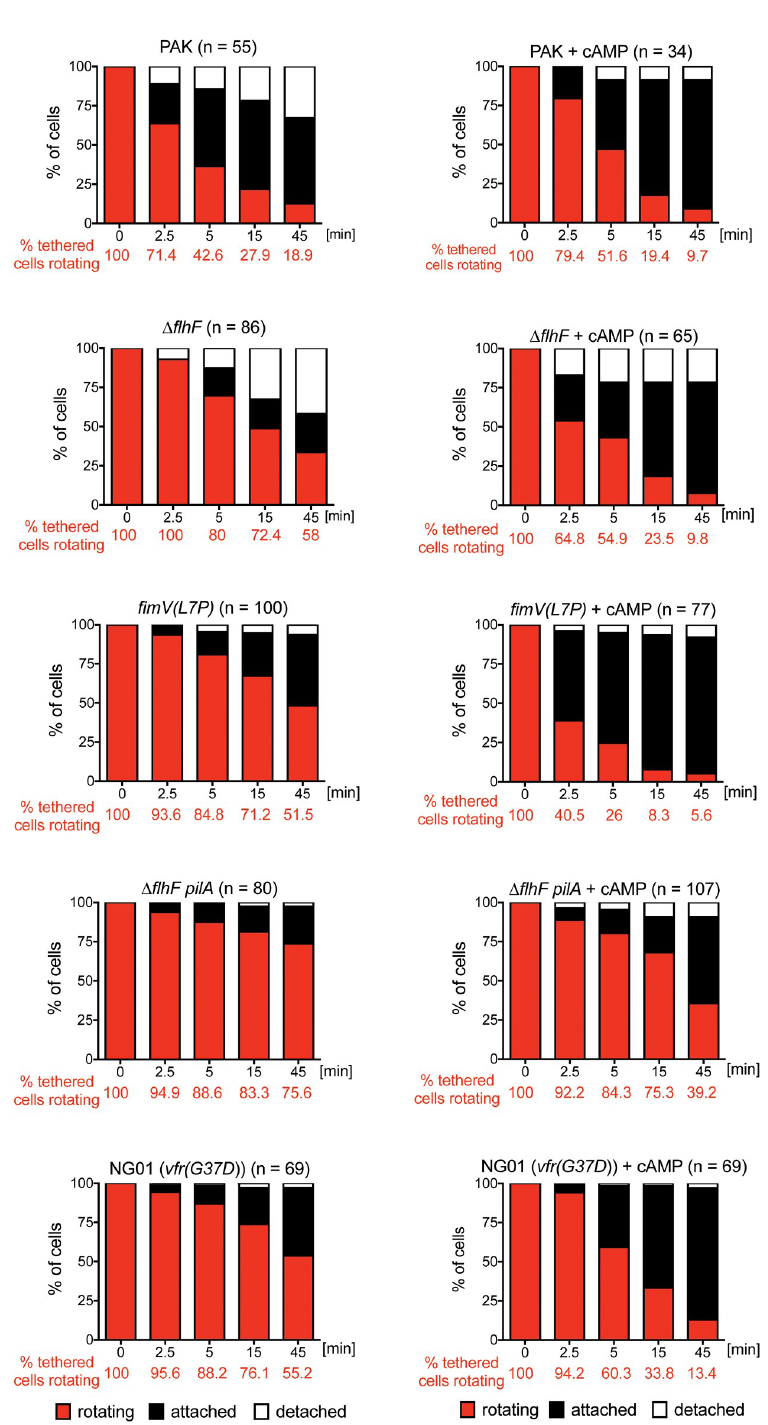
Fig 6. Exogenous cAMP reverses the persistent rotation phenotype of surface-tethered flhF , fimV and vfr mutants. Bacteria were incubated with anti-FliC coated slides for 5 min in the presence or absence of 20 mM cAMP. Rotating bacteria were identified (t = 0) and observed for 45 min. The proportion of rotating (red), attached (black), and detached cells (white) was determined in 3–8 independent experiments. Survival curves were analyzed with the Mantel-Cox test to determine whether exogenous cAMP had a significant effect on persistence of rotation. This was the case for Δ flhF , fimV(L7P) , NG01( vfr(G73D) ) and Δ flhF pilA ( p < 0.0001), but not for the parental strain PAK ( p =